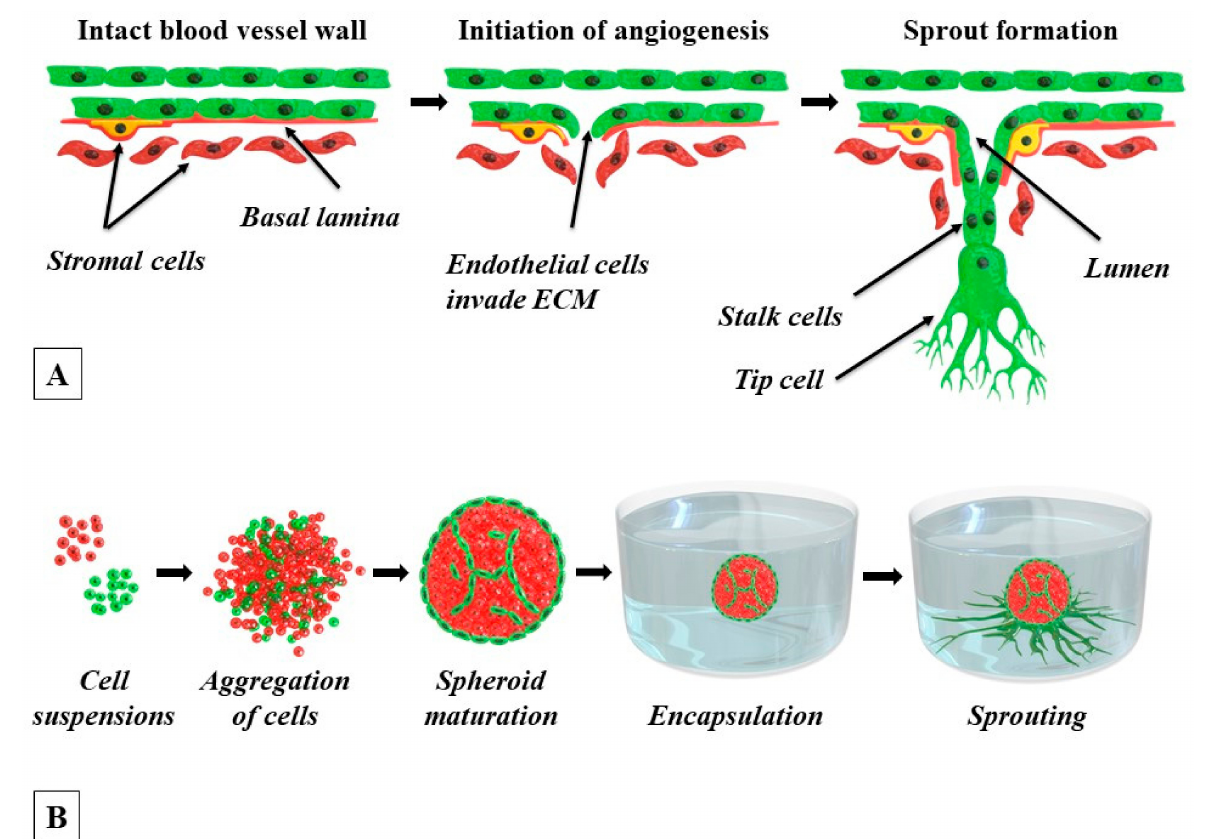
Figure 1. Schematic diagram of natural angiogenesis and it’s modeling in vitro using tissue spheroids. ( A ) The key steps of in vivo angiogenesis. Some ECs (green) from the vascular wall are activated in response to signals from the surrounding tissues. They initiate the cascade of processes, such as secretion of MMPs, decomposition of the basal lamina, migration towards the source of chemotactic stimuli, proliferation, and tube formation, providing the sprouting of cells from the mature endothelial layer of the vessel wall. The tip cell produces pseudopodia that guide the development of the capillary sprout as it grows into the surrounding tissue. The stalk cells provide the elongation of the sprout through extensive proliferation. As the sprouting progresses, the surrounding stromal cells (pericytes (yellow), fibroblasts (red), and also the mesenchymal stem cells, MSCs) begin to attach to the growing sprout, thus providing support and stabilization. At the late stages, the capillary sprout hollows out to form a tube. ( B ) Workflow steps of 3D angiogenesis sprouting assay. Isolation and in vitro expansion of ECs (green color) and stromal (red color) cells; mixing several populations of